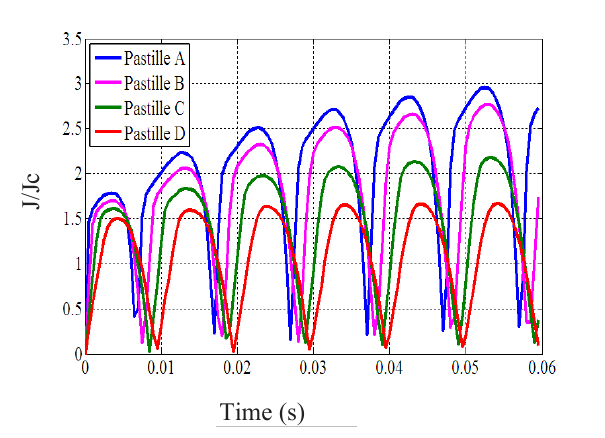
Table3: The transition time from the superconducting